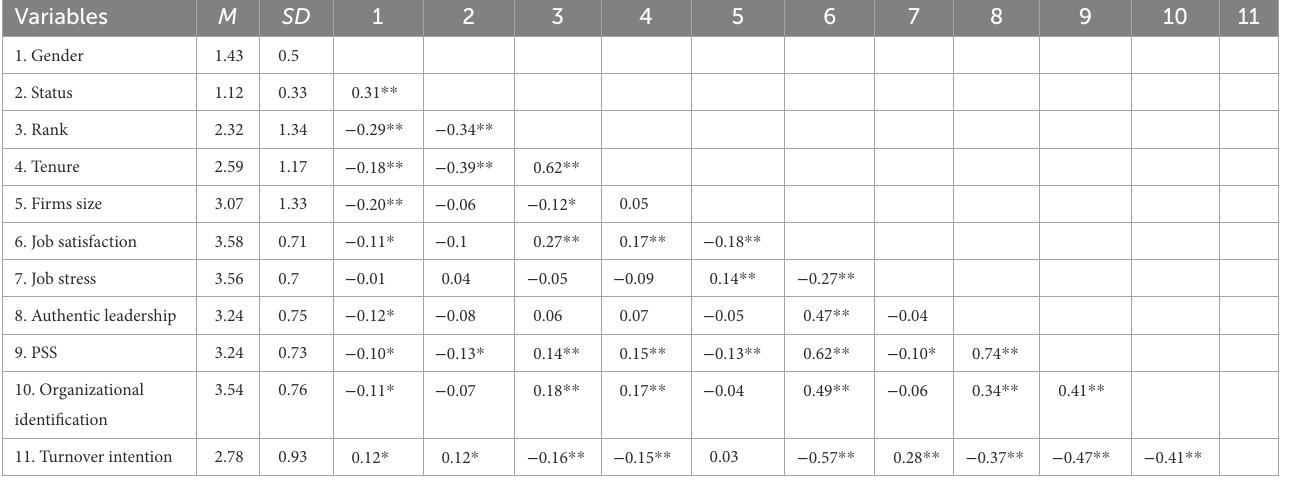
TABLE 2 Correlations and descriptive statistics.